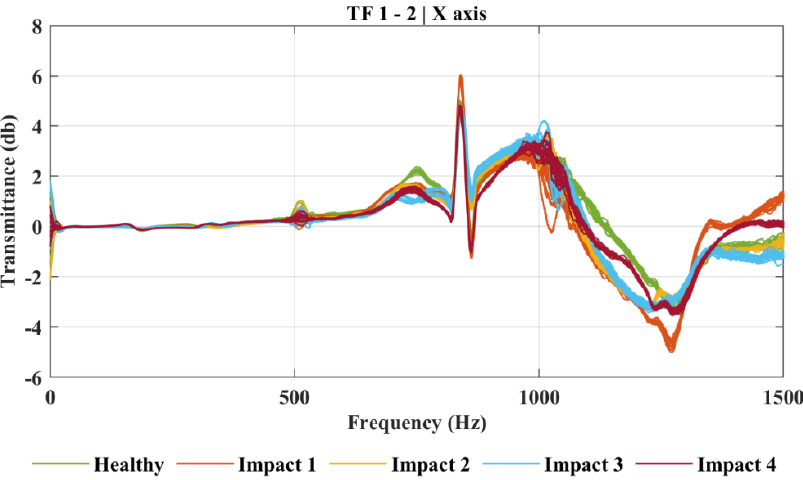
Figure 6. Transmittance functions (TF) on X-axis between accelerometer A1 and accelerometer A2.